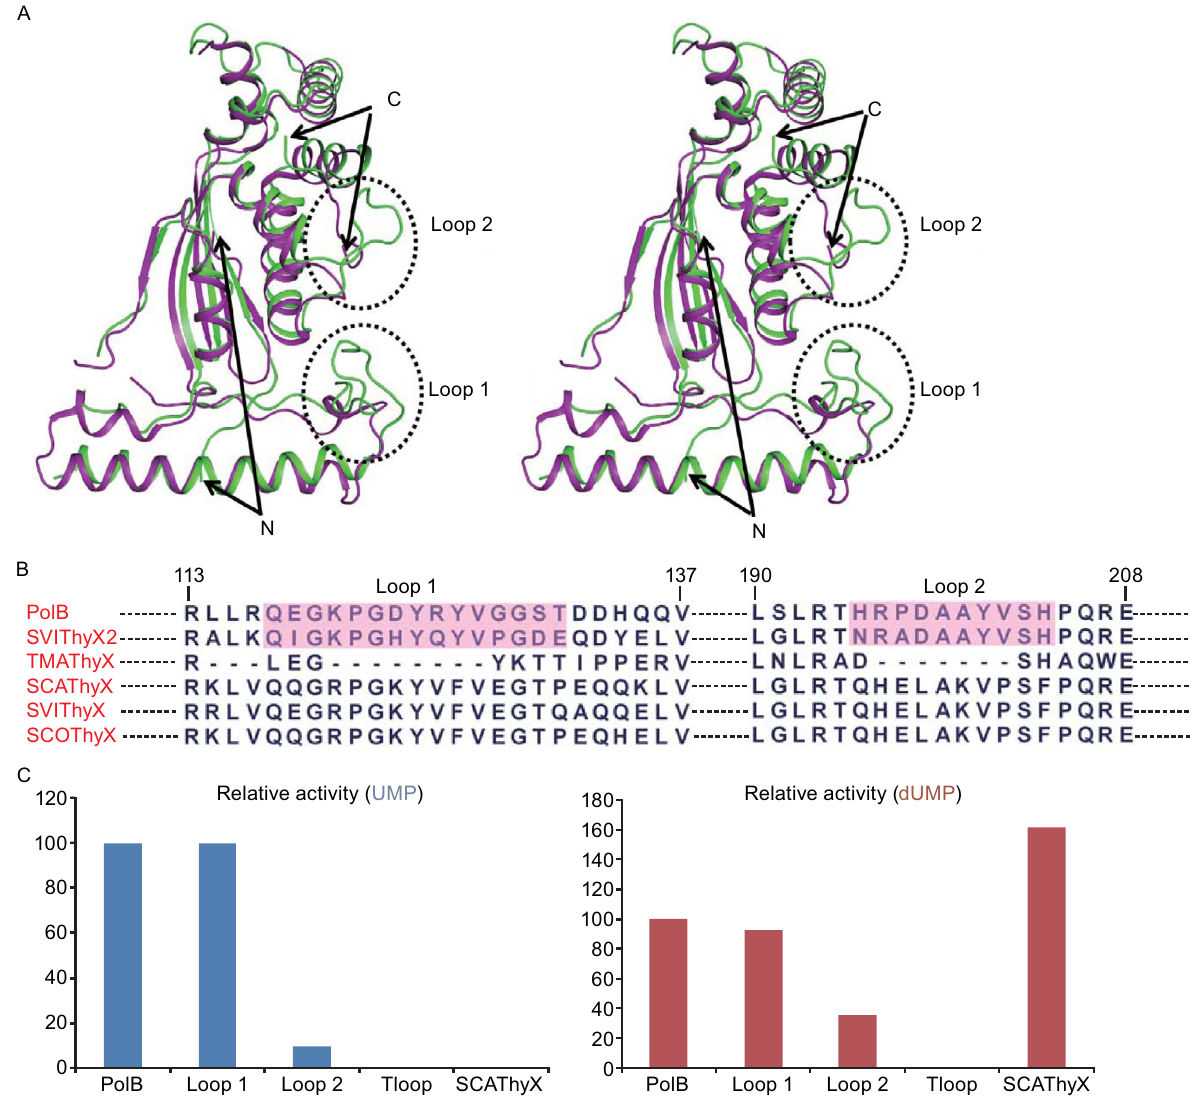
Figure 4. Comparison of PolB and ThyX proteins. (A) Superposition of PolB and TMAThyX (PDBID: 1O2A). PolB is shown in green, and TMAThyX is shown in purple. The N-and C-terminus are indicated. (B) Alignment of Loop 1 and Loop 2 between PolB and homologous ThyXs from Streptomyces . The residues in Loop 1 and Loop 2 of PolB and SVIThyX2 are boxed in magenta. (C) Comparison of the catalytic activities of ThyX, PolB and PolB variants for UMP (left panel) and dUMP (right panel). The relative activity was calculated on the basis of 3 repeats, and the error was all under control of